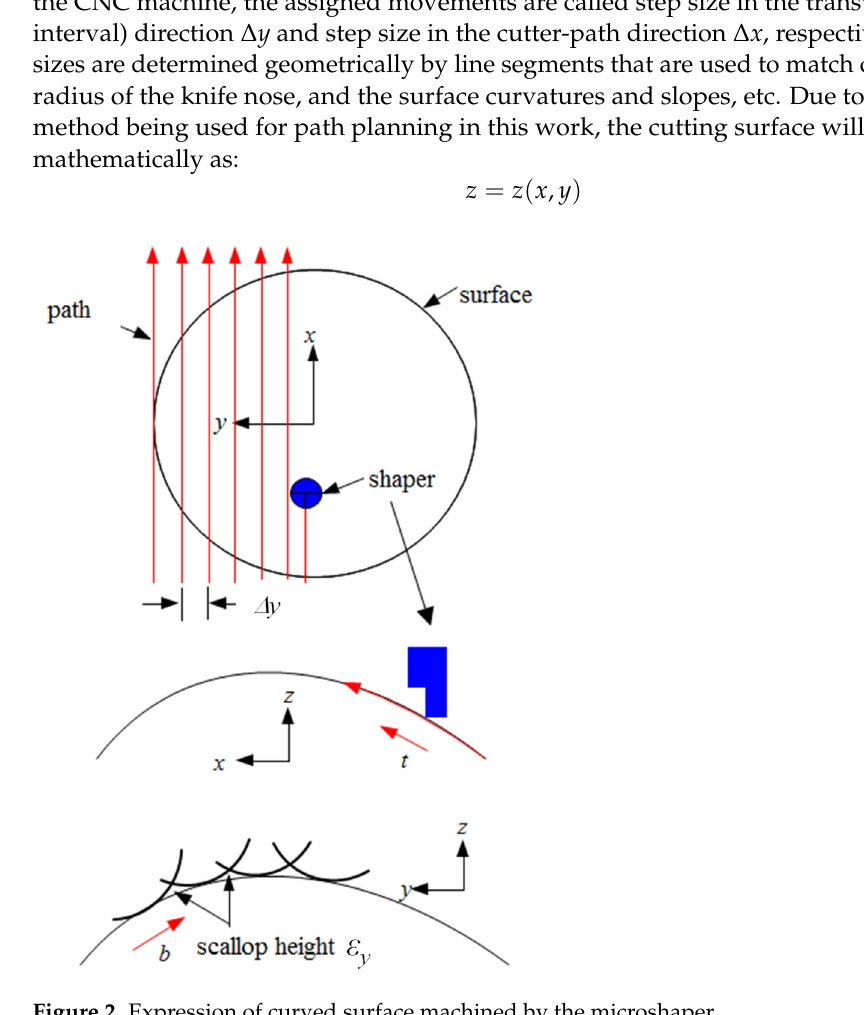
Figure 2. Expression of curved surface machined by the microshaper.